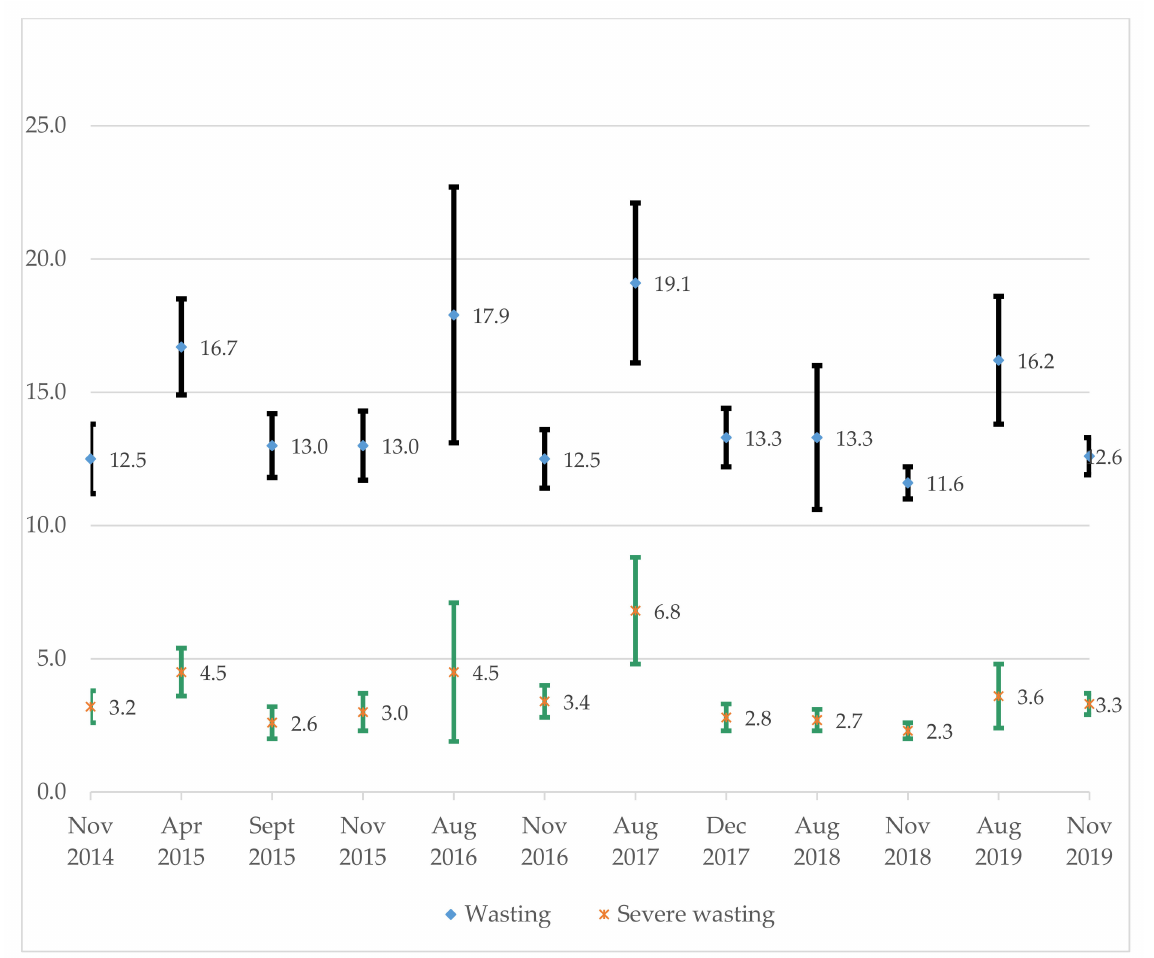
Figure 2. Trends in the prevalence of child wasting. Note: Data compiled from FSNMS surveys. Wasting = weight-for height < − 2 Z-scores and/or bilateral oedema; Severe wasting = weight-for height < − 3 Z-scores or bilateral